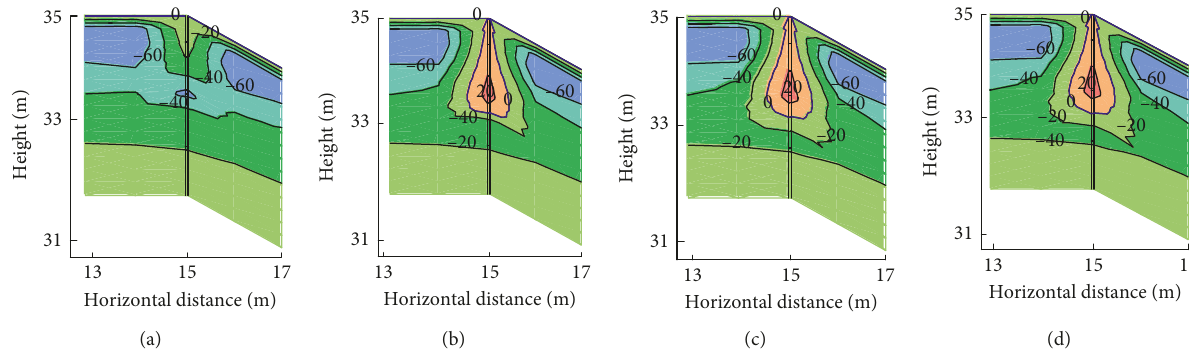
Figure 9: Pore water pressure cloud images of the fracture zone with different permeability coefficient ratios (fracture depth 3m, unit: kPa): (a) μ 1; (b) μ 10; (c) μ 100; (d) μ (cid:31) (cid:31) (cid:31) (cid:31)